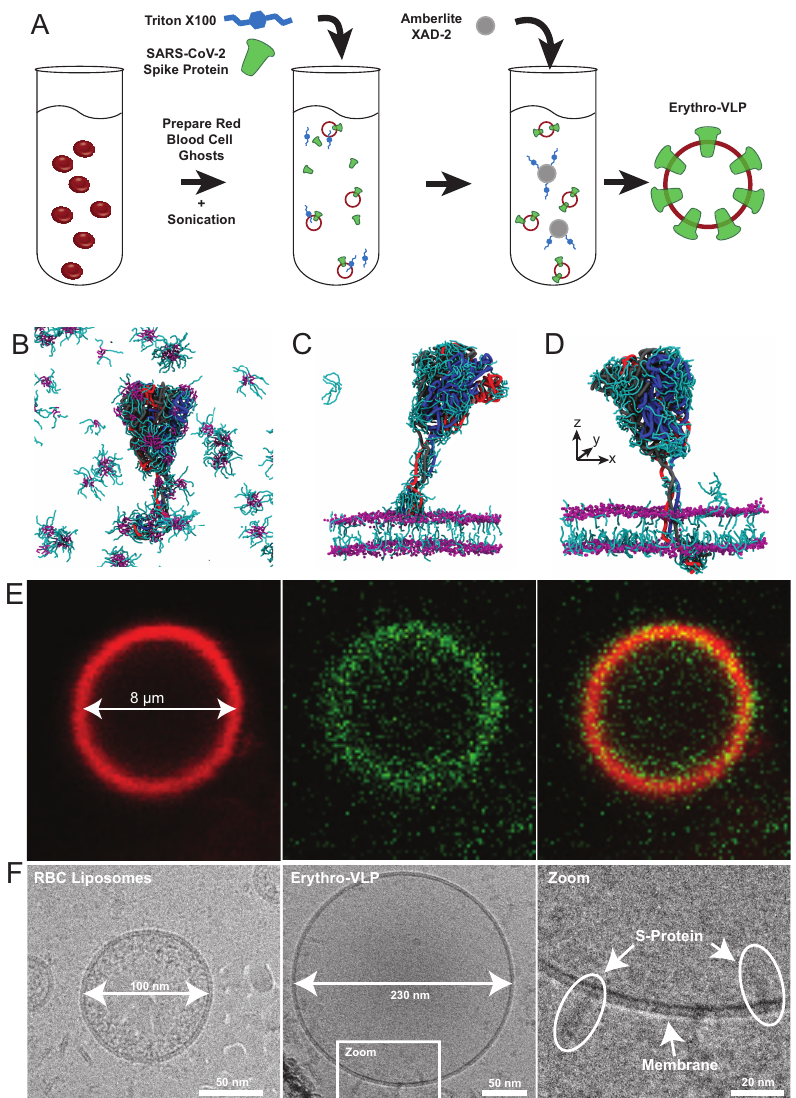
Figure 3. ( A ) Preparation protocol for Erythro-VLPs: Erythrocyte liposomes were prepared from human RBCs. Erythrocyte liposomes were incubated with S-protein in a surfactant (Triton-X 100) solution to facilitate protein entry into the membranes. Triton-X 100 was then removed using Amberlite XAD-2 resin beads and subsequent size-exclusion chromatography. ( B ) MD simulation show that the surfactant stabilizes the protein and protects the hydrophobic transmembrane domain. ( C , D ) show details of the insertion process. ( E ) Fluorescent microscope images of a giant Erythro-VLP with membrane stained in red, and S-proteins stained in green. ( F ) shows high-resolution cryo- TEM images of the erythrocyte liposomes before protein insertion, and with S-proteins embedded. Figure adapted from